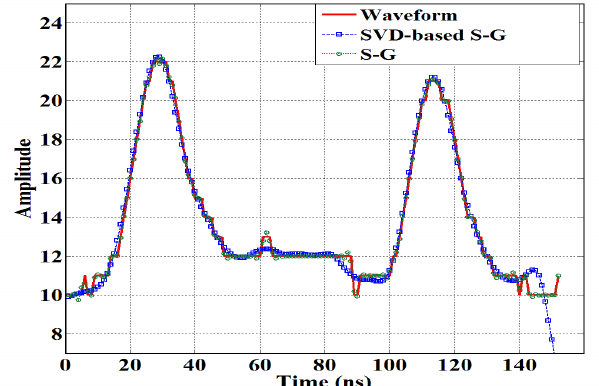
Figure 4. Comparison of the SVD-based S-G and S-G filters